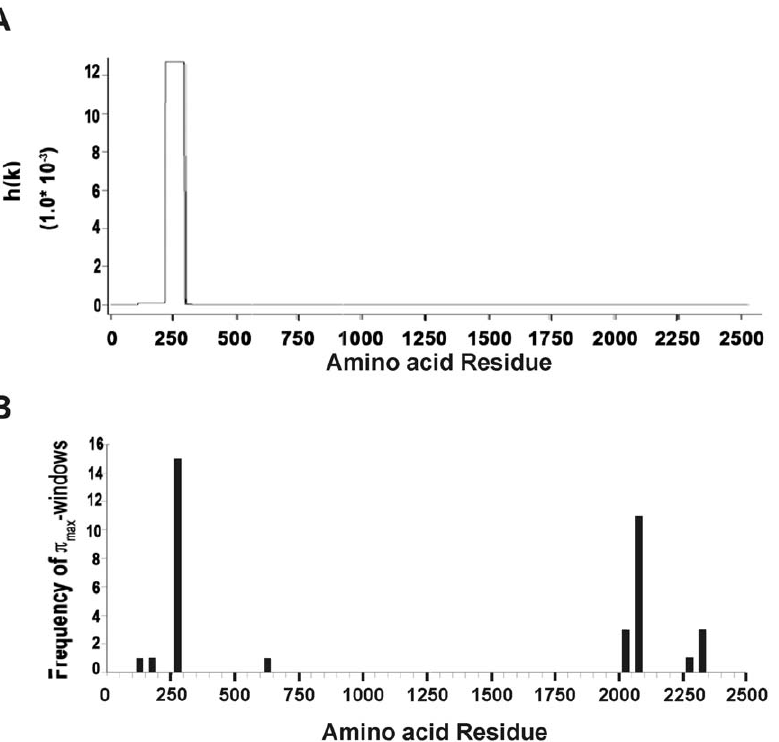
Figure 1. Predicted LRRK2 aggregation domains. ( A ) The PASTA algorithm by Trovato [19] predicts an aggregation domain at 210–310 amino acid residues in the LRRK2 protein (NCBI accession number NP_940980). ( B ) An independent aggregation algorithm [21] predicts two aggregation domains, one peak between amino acid residues (250 to 299) overlapping with the N-terminus region predicted by PASTA (A) and the other at amino acid residues 2050–2099. Tick marks in B represent sliding window of 50 amino